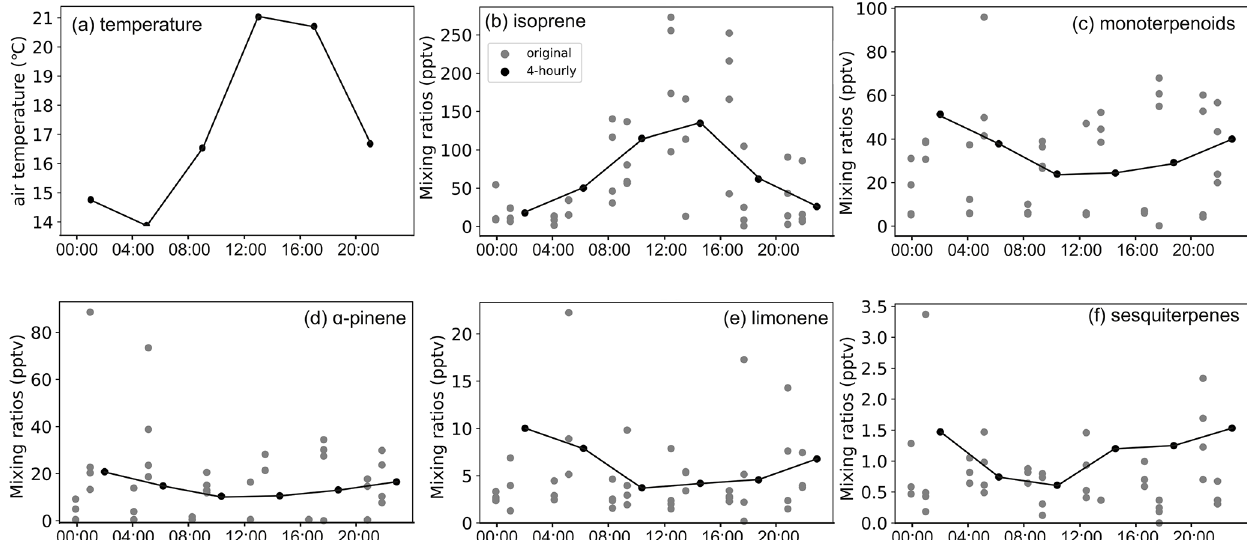
Figure A7. BVOC mixing ratios in the highland site during the dry season. Panels (b) to (f) share the same labels.